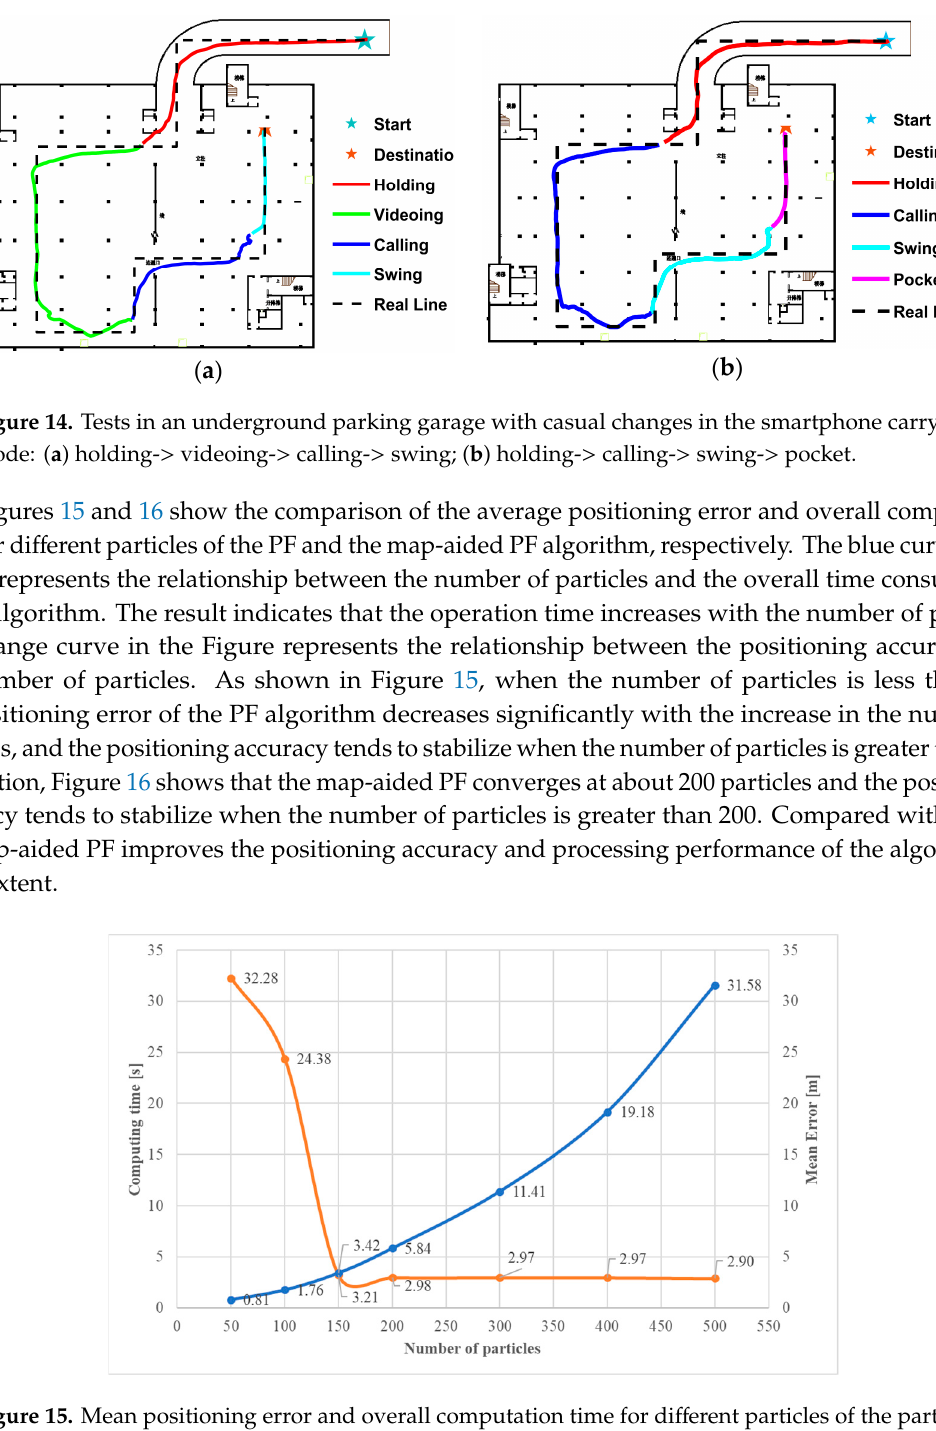
Figure 15. Mean positioning error and overall computation time for different particles of the particle filter (PF) algorithm.